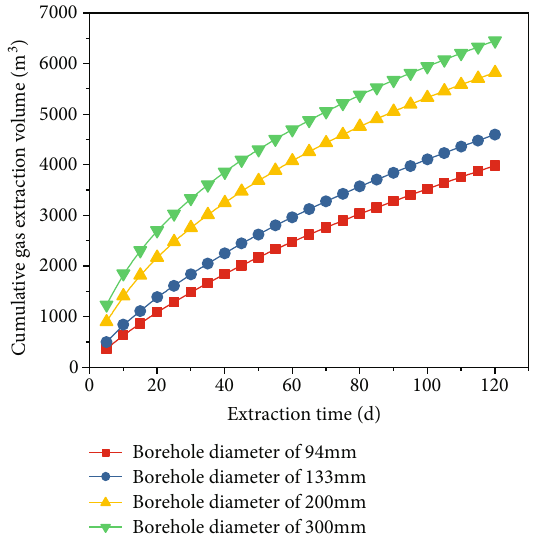
Figure 18: Variation of cumulative gas extraction volume under di ff erent borehole